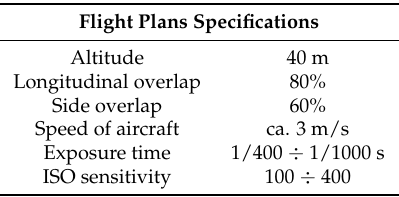
Table 2. Flight plan specifications.